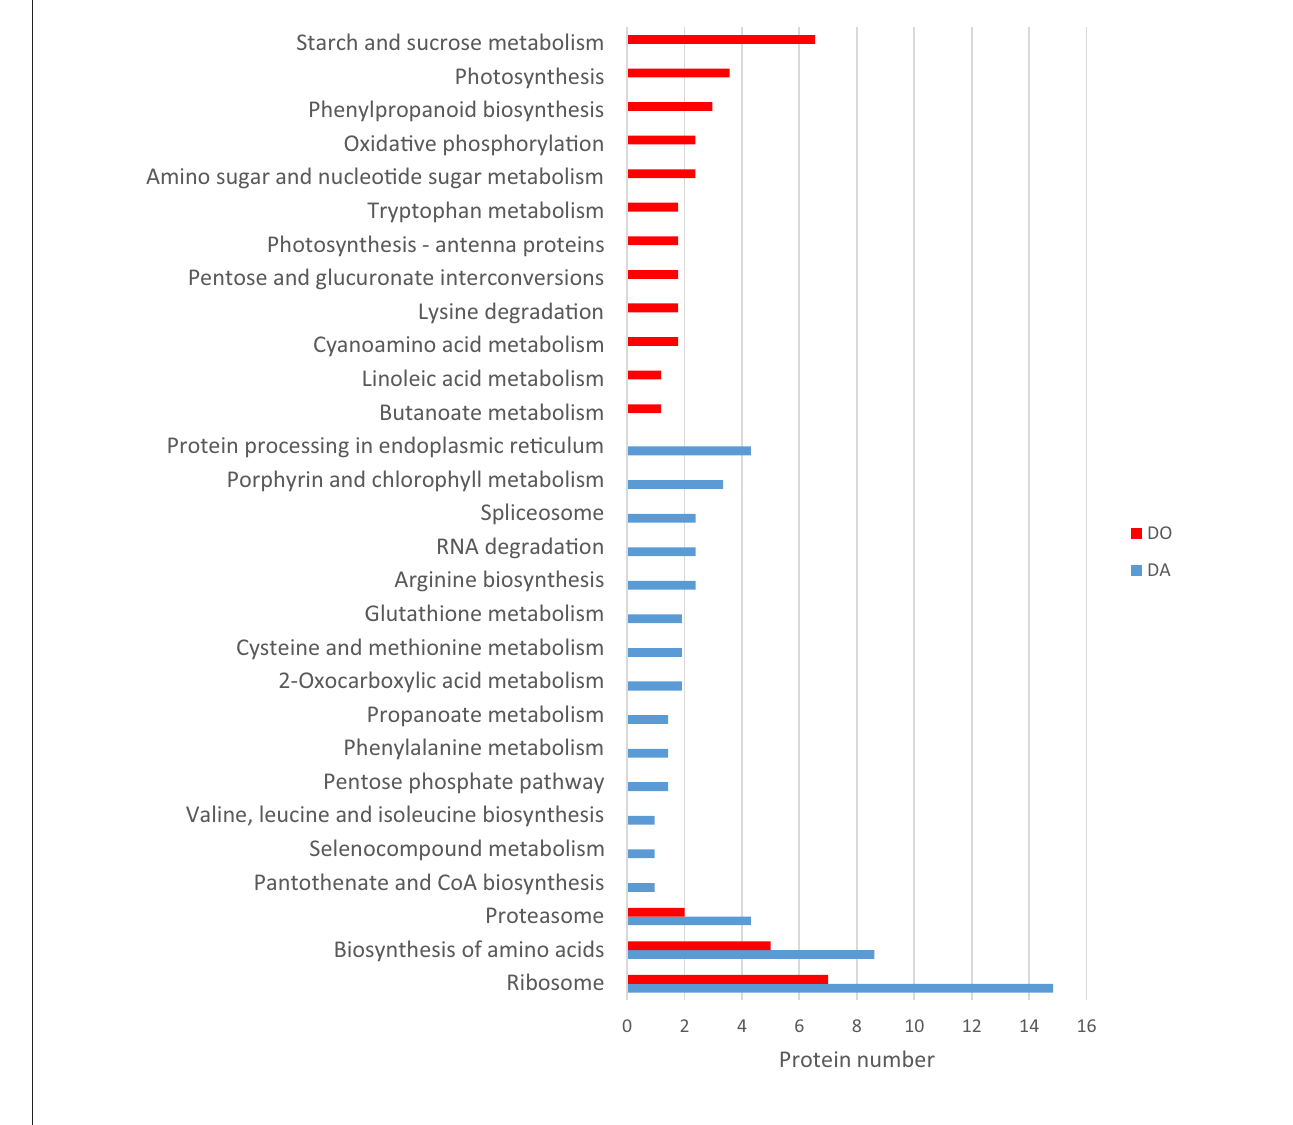
PAF1 complex (PAF1C), involved in epigenetic gene